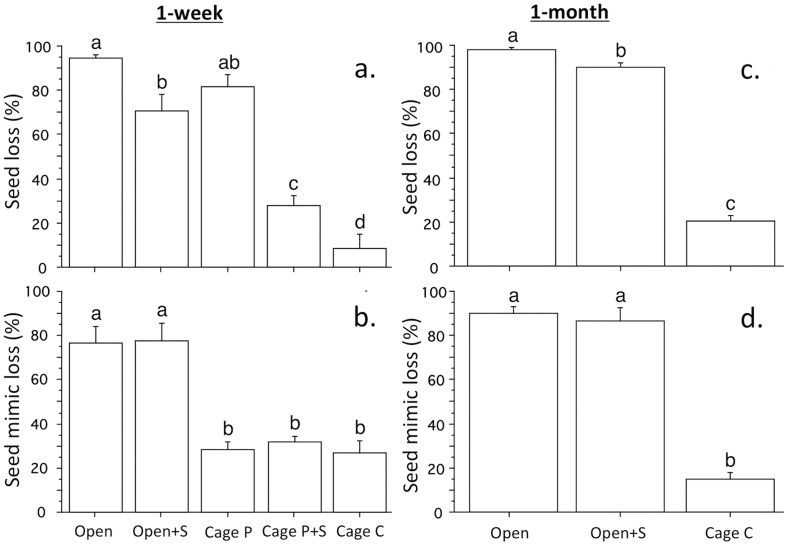
One-week and one-month cage experiment.Loss of (a) eelgrass seeds and (b) seed mimics in the one-week, and loss of (c) eelgrass seeds and (d) seed mimics in the one-week. Seeds with: no cage (Open), no cage + sand cover (Open+S), cage + shore crab (Cage P), cage + shore crab + sand cover (Cage P+S) and cage (Cage C). Different letters above bars denote significant different means (SNK-test at P<0.05). 200 eelgrass seeds and 20 seed mimics used per experimental. Mean+SE.